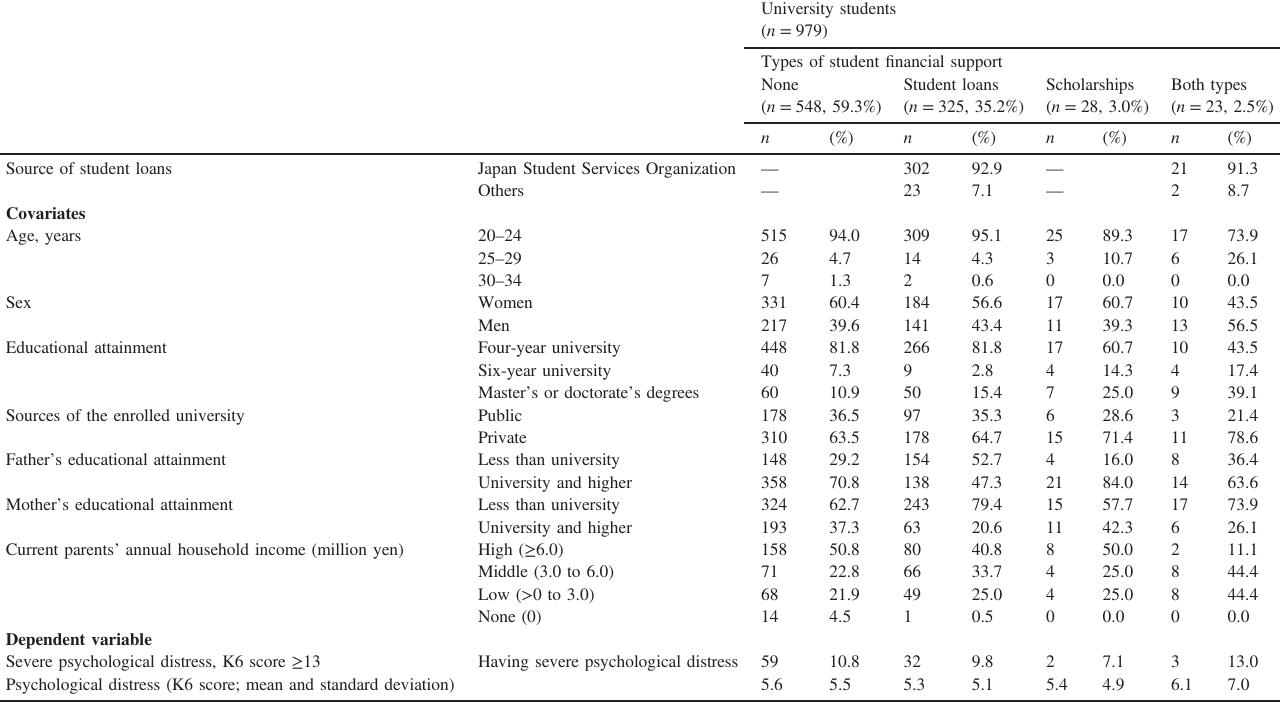
University students ( n = 979)